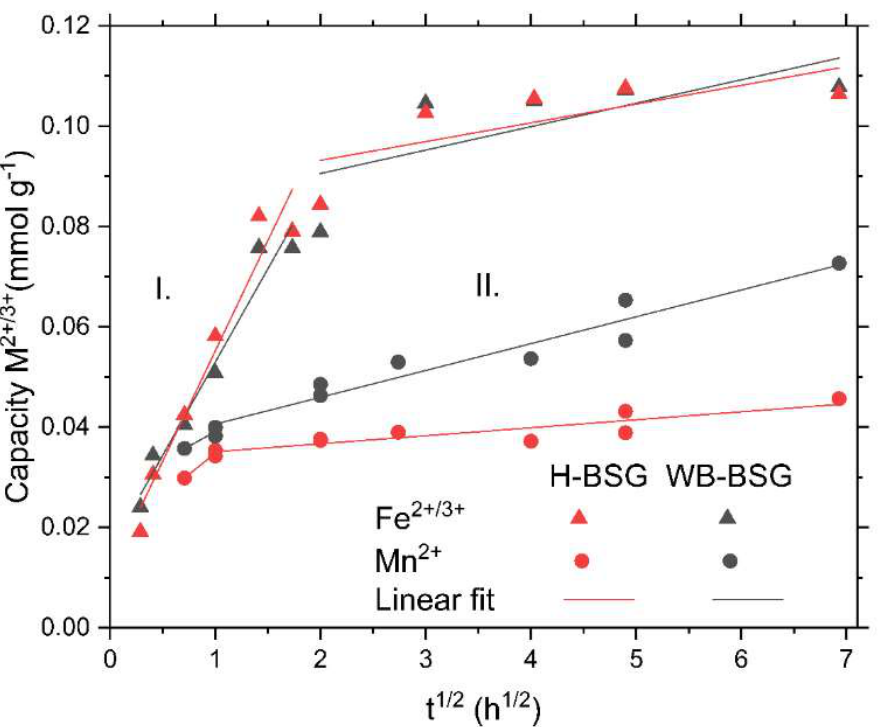
Figure 6. Adsorption kinetics of Fe 2+/3+ and Mn 2+ onto H-BSG and WB-BSG transformed as q vs. t 1/2 . From batch experiments with c 0 = 0.36 mmol/L Fe 2+/3+ or Mn 2+ , a BSG dosage of 3.33 g/L, stirred at r.t. and measured at respective times. Curves present respective fitted kinetic models, model pa- rameters given in Table S6.